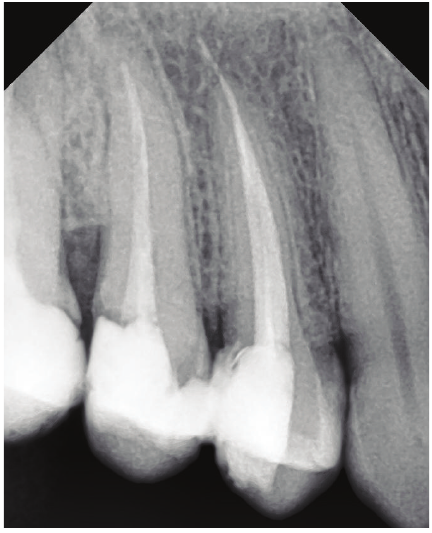
Figure 2: One root with two canals shared one apical